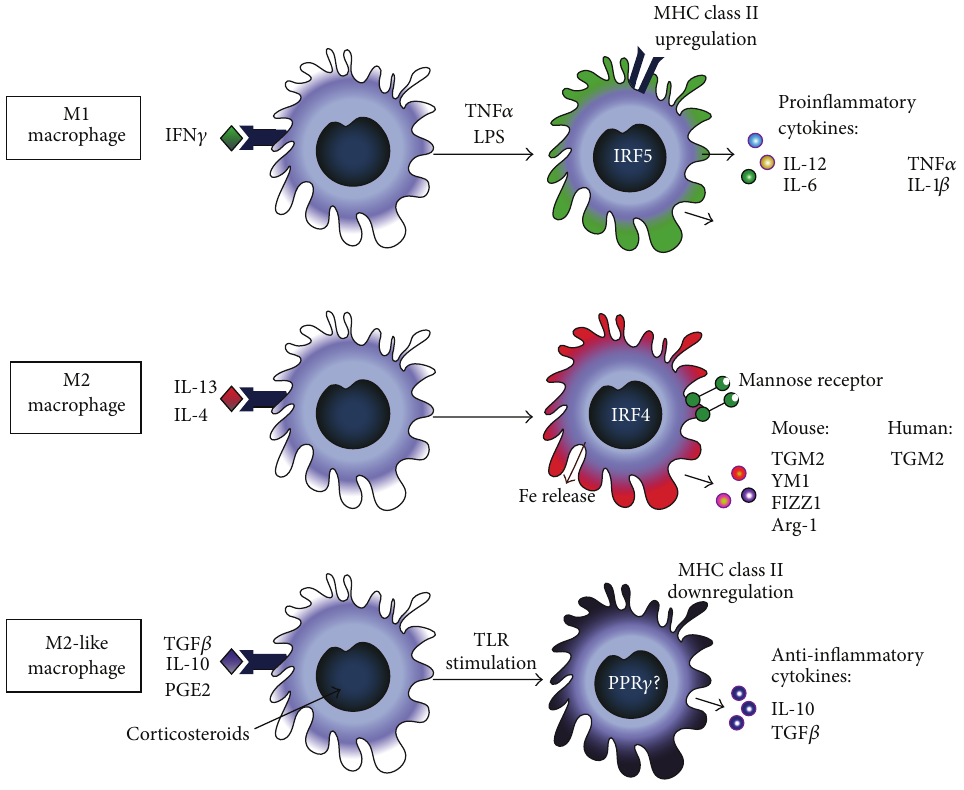
Figure 1: Schematic representation of the three macrophage phenotypes and their characteristics. IFN 𝛾 : interferon gamma; TNF 𝛼 : tumor necrosisfactoralpha;LPS:lipopolysaccharide;MHCclassII:majorhistocompatibilitycomplexclassII;IL:interleukin;NO:nitricoxide;IRF5: interferon regulatory factor 5; Fe: iron; TGM2: transglutaminase 2; YM1: chitinase-3-like protein-3; FIZZ1/Relm 𝛼 : resistin-like molecule- 𝛼 ; Arg-1: arginase-1; TGF 𝛽 : transforming growth factor beta; TLR: Toll-like receptor; PGE2: prostaglandin E2; PPAR 𝛾 : peroxisome proliferator- activated receptor